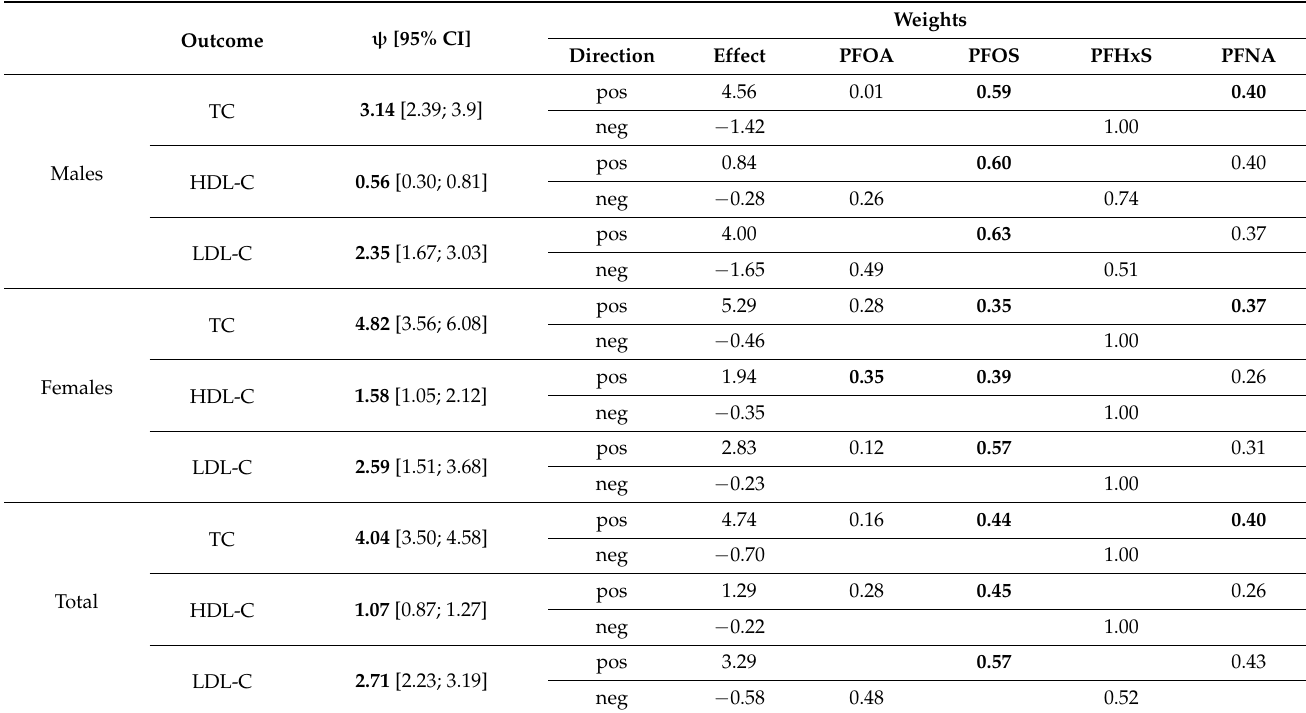
Table 3. Associations between Quantile G-computation regression index and serum lipids (mg/dL). Quantile G-computation estimates * and 95% confidence intervals for the change in TC, HDL-C and LDL-C, stratified by sex. Q-Gcomp regression model weights of each PFAS component, for each outcome.